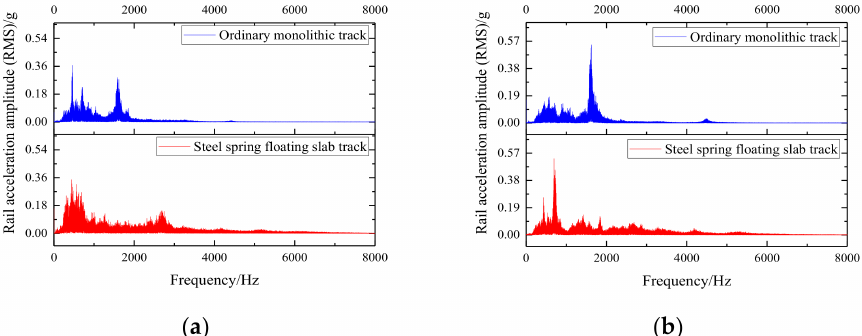
Figure 13. Comparisonofverticalfrequencyspectrumofrail. ( a )Straightlinesegment; ( b )curvedsegment.